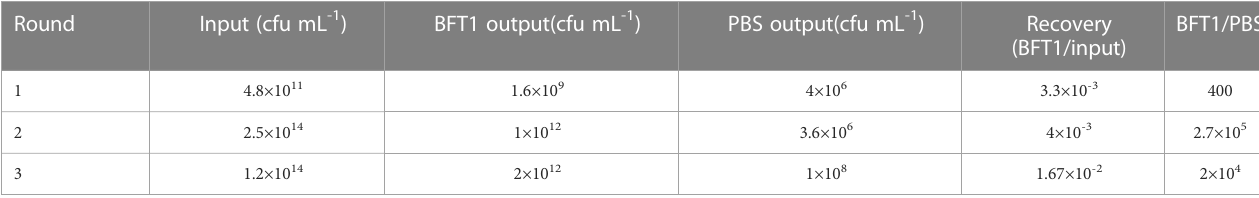
TABLE 2 Enrichment of phages with each consecutive round of bio-panning.